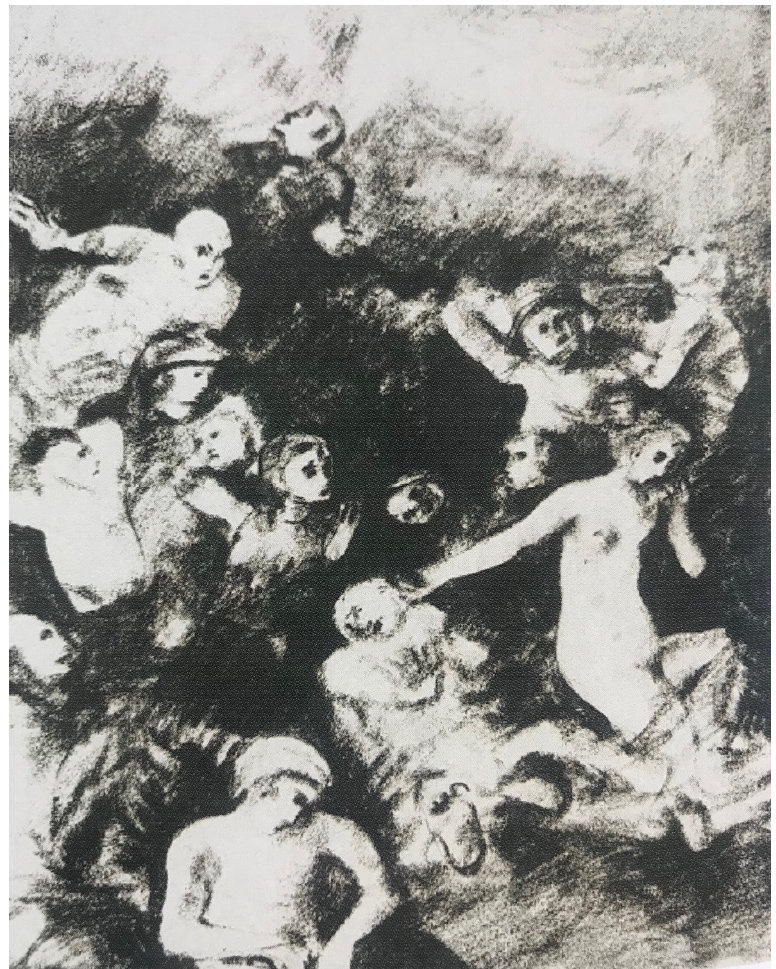
Figure 8. Vasily Chekrygin, fragment of a fresco on the theme of The Raising of the Dead, 1921, charcoal on paper, State Tretyakov Gallery, Moscow.